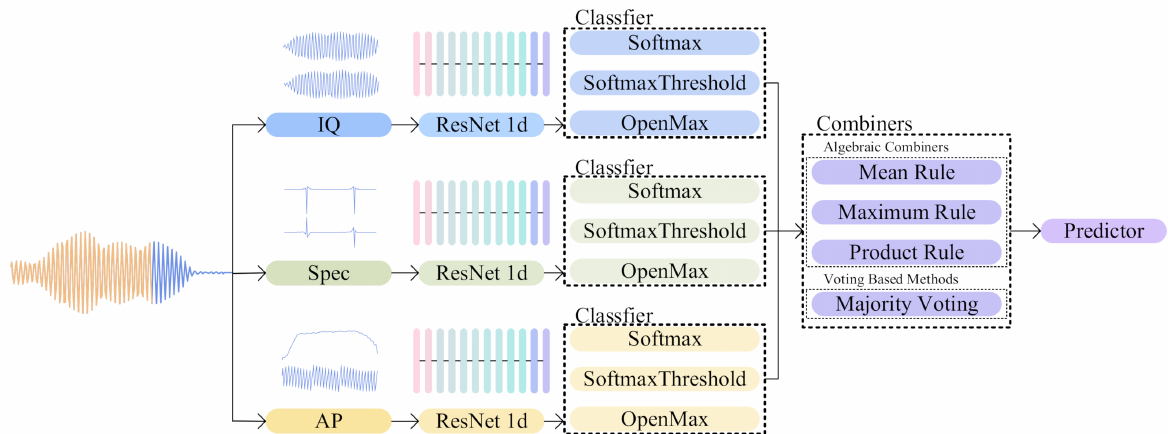
Figure 4. Classifier fusion framework for open-set SEI. Intercepted signals (in blue) are segmented as the predesigned length. Segments (in orange) are then transformed into IQ, Spec., and AP for three independent channels. Each channel is assigned with a ResNet for extracting fingerprint features. ResNet is composed of several basic blocks, which are represented in different colors (seen in Figure 5b). Then a multi-classifier fusion method is applied to predict device